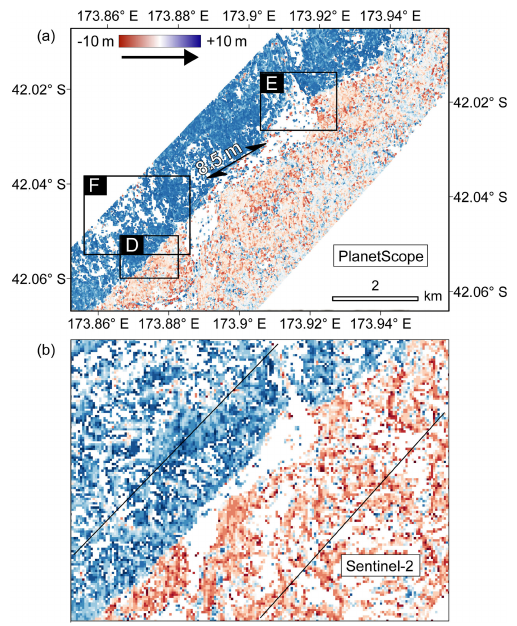
Figure 4. (a) Horizontal surface displacements from PlanetScope images of 27 October–21 November 2016, W–E component (S–N component is very similar). The double arrow indicates the approx- imate direction and the according number the approximate mag- nitude of relative displacement over the main rupture. Location of Figure: B in Fig. 1. Rectangle D: Fig. 6, rectangle E: Fig. 7, rectan- gle F: Fig. 8. (b) As upper panel but displacements from Sentinel-2 data of 3 October and 5 December 2016; same colour